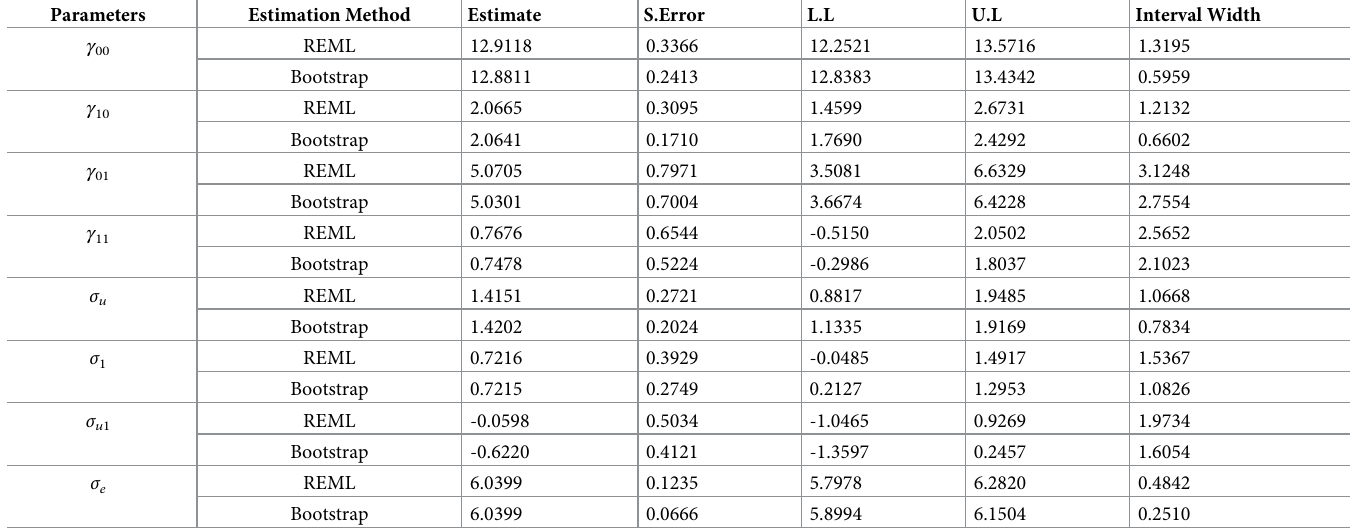
Table 11. Fixed and random effects parameter estimates and CI Limits under both REML and bootstrap by means of MINQUE methods of estimation for real data.